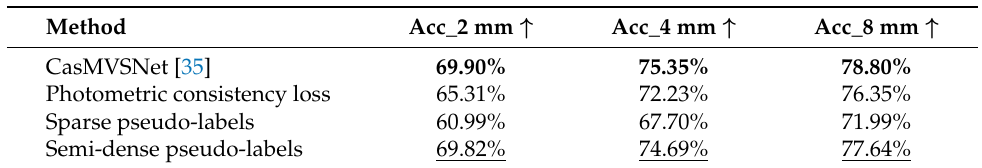
Table 6. Qualitative results of depth estimation on the DTU dataset (lower is better). The best results are in bold, while the second ones are underlined.